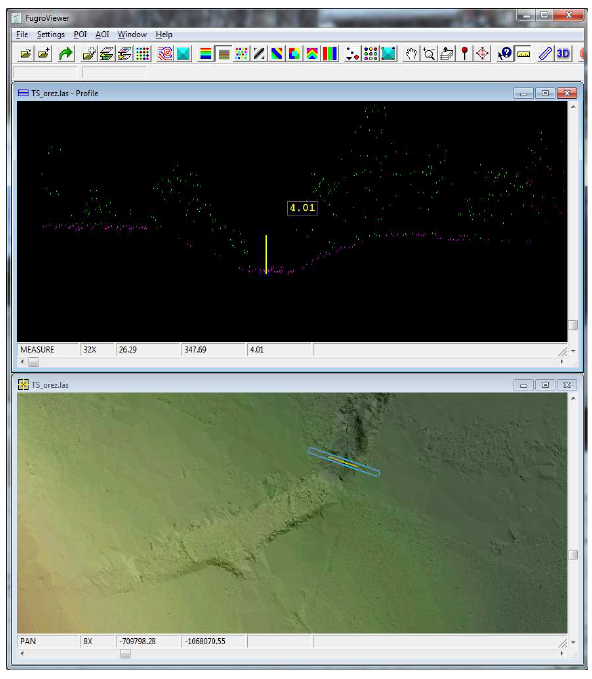
Figure 6. Cross section methods – they are not able to create DTM in forested